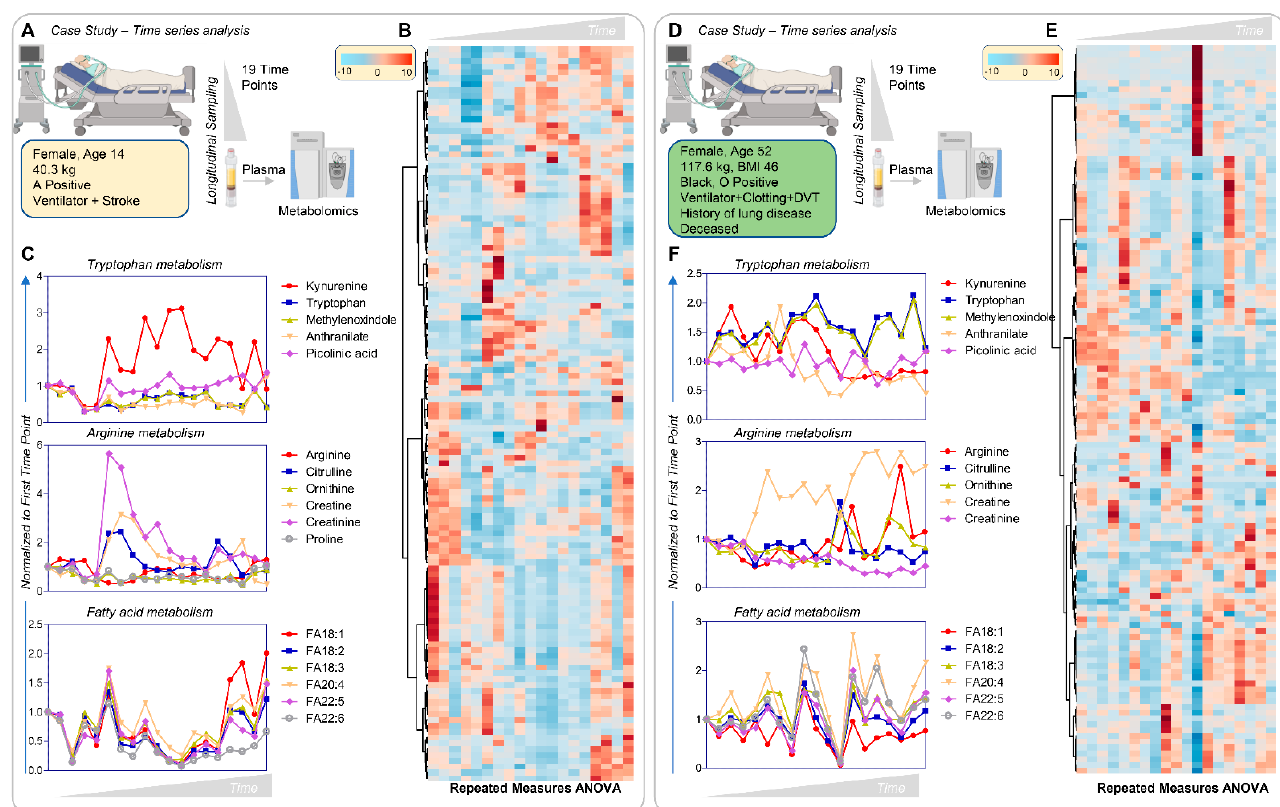
Figure 8. Time-course analysis of two patients with severe COVID-19, one surviving ( A – C ) and one dying ( D – F ) of disease. Both patients were ventilated with coagulopathic complications, either stroke or deep vein thrombosis. The first patient, a 14-year-old female with no pre-existing conditions, survived at the end of the time course and manifested transient activation of the kynurenine pathway and accumulation of creatinine (kidney dysfunction), which resolved early ( C ). This patient was also characterized by late accumulation of plasma free fatty acids (18C, 20C, and 22C poly- and highly unsaturated fatty acids). The second patient, a 52-year-old female with a history of obesity and lung disease, did not survive COVID-19; no activation of the kynurenine pathway was observed and creatine levels remained elevated.